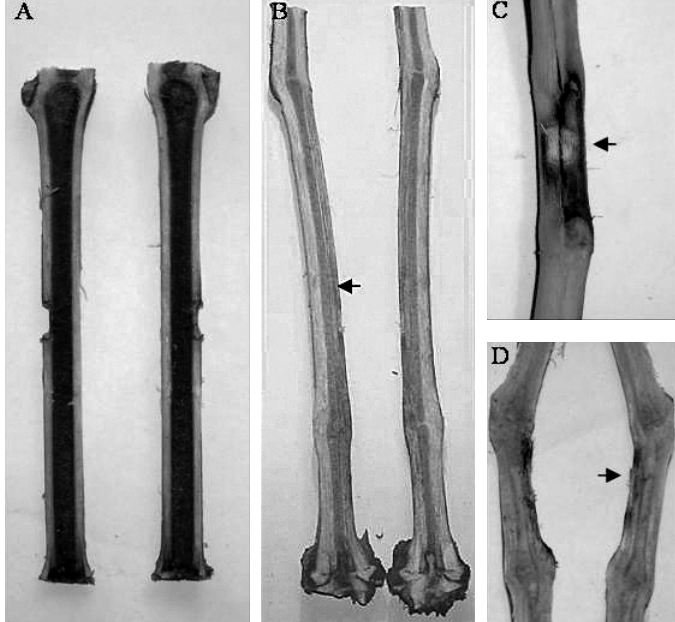
Figure 1. Lesions on stems/trunks of 2-year-old nursery plants 3 months after inoculation. A) Rootstock inoculated with sterile agar plug. B) Rootstock inoculated with Greeneria uvicola . C) Scion inoculated with G. uvicola (external lesions on xylematic tissues). D) The same scion as in C showing internal lesion in xylem.